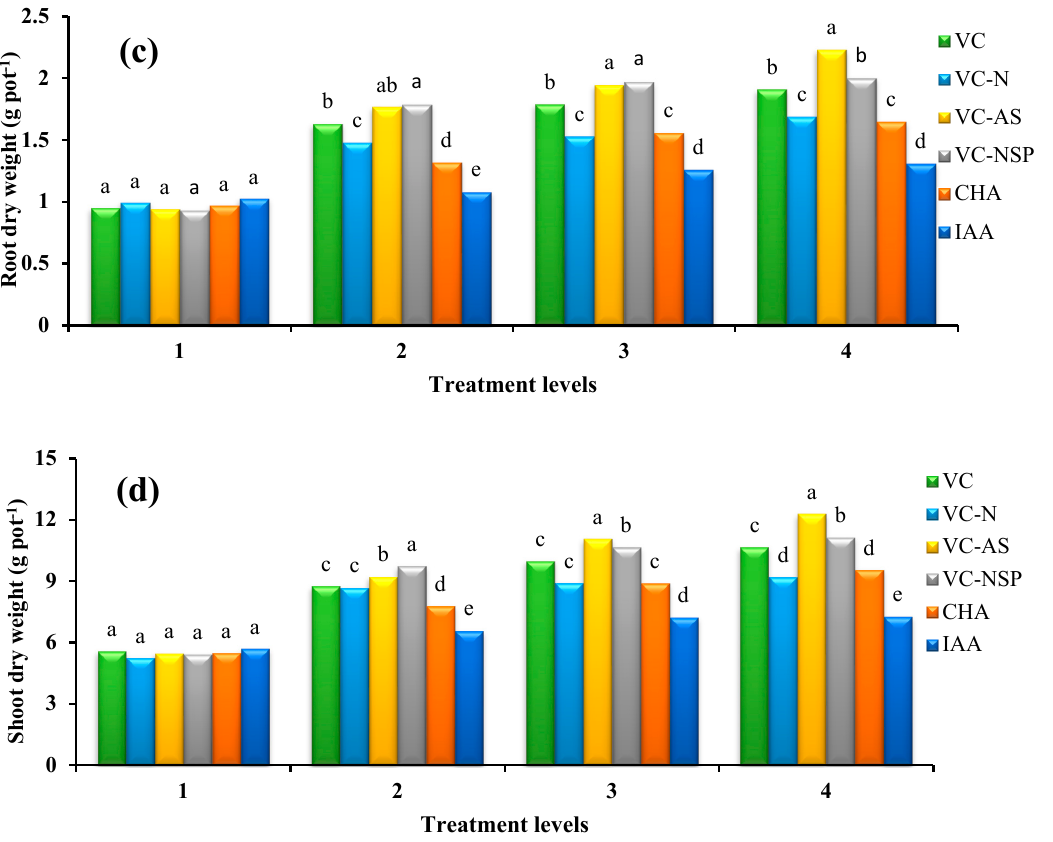
Figure 4. Comparison of average soil application of experimental treatments on shoot fresh weight ( a ), Root fresh weight ( b ), root dry weight ( c ) and shoot dry weight ( d ) at treatment levels (levels 1, 2, 3 and 4 for VC, VC-N, VC-AS and VC-NSP treatments of 0, 1, 2 and 3% VC, 0, 200, 400 and 600 mg of CHA per kg of soil and 0, 10 − 6 , 10 − 5 and 10 − 4 molar IAA). Different letters in each figure show significant difference at p ≤ 0.05 by Duncan multiple range test. VC, VC without enrichment; VC-N, VC enriched with 1% nitrogen; VC-NSP, VC enriched with 1% nitrogen, 1% sulfur, and 1% phosphorus; VC-AS, VC enriched with Azotobacter chroococcum (21Az) + Pseudomonas fluorescens (Ps 59); CHA, Commercial humic acid; IAA, Indole-3-acetic acid.